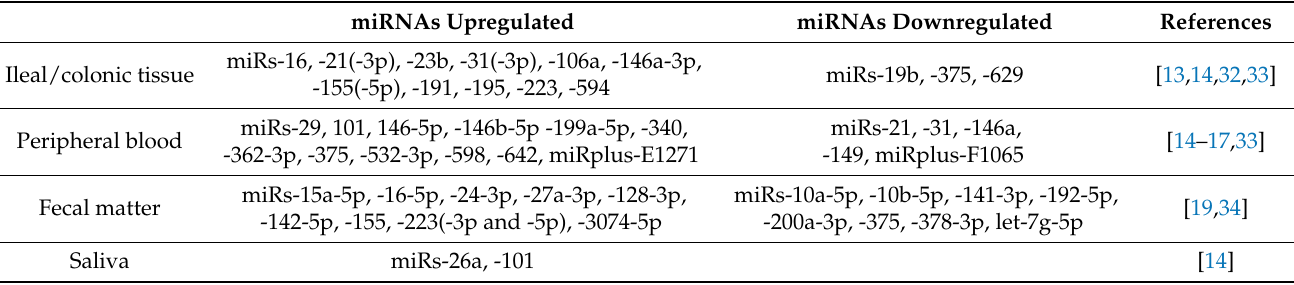
Table 2. miRNAs dysregulated in CD across various tissue samples. miRNAs Upregulated miRNAs